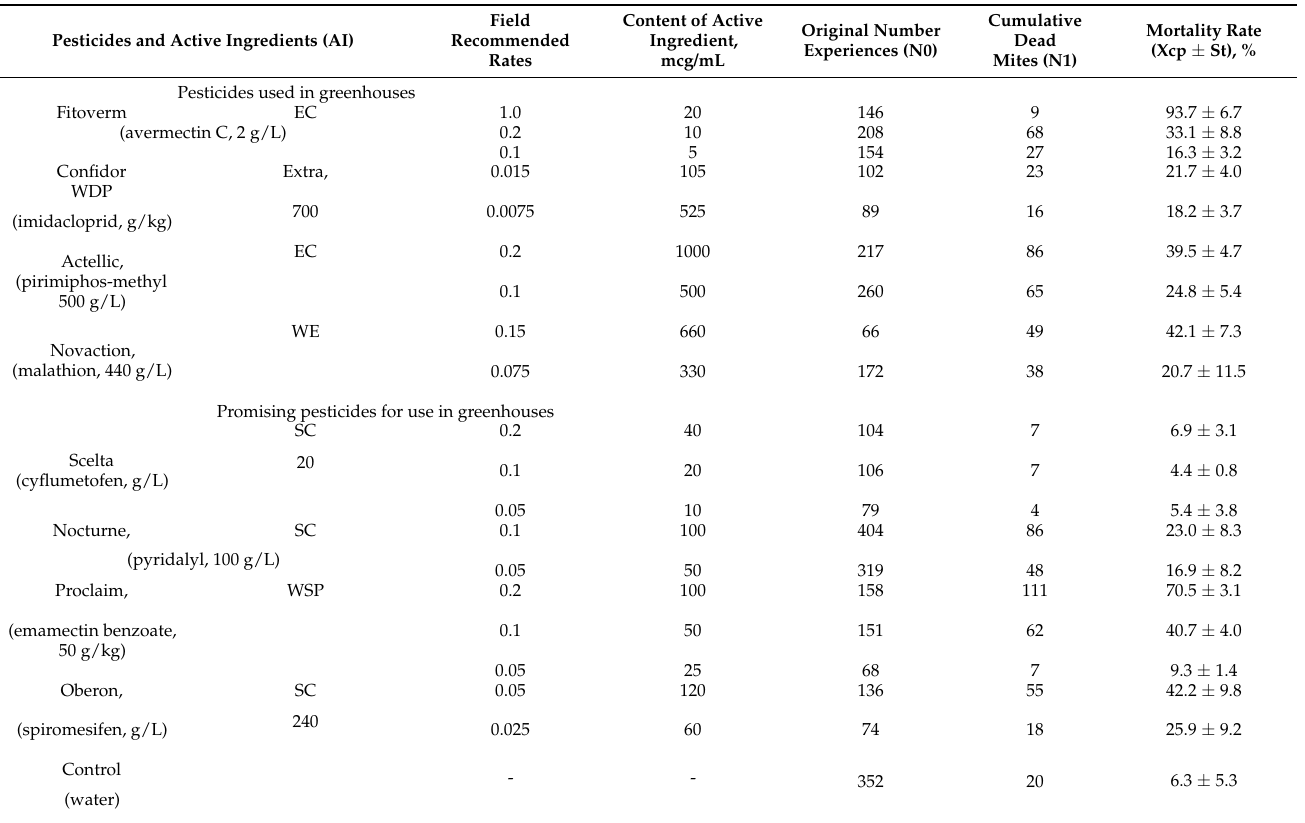
Table 2. Potency of different classes of pesticides against mites